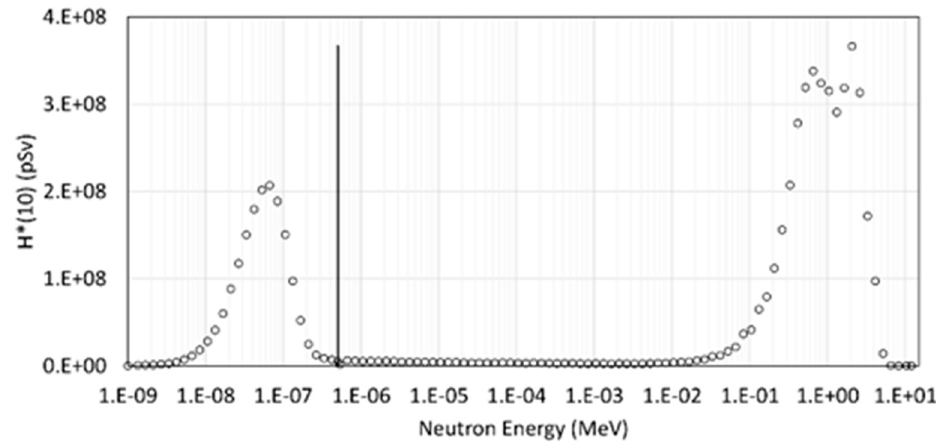
Figure 5. Ambient dose equivalent (H*(10)) as a function of the neutron energy. The vertical solid black line indicates the energy level of 0.5 eV.